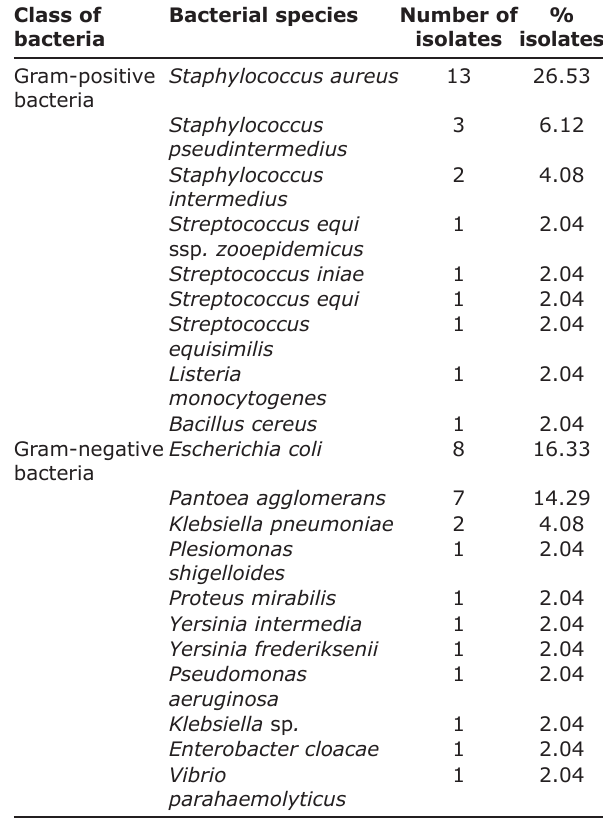
Table-1: Bacterial species isolated from equine wound swab